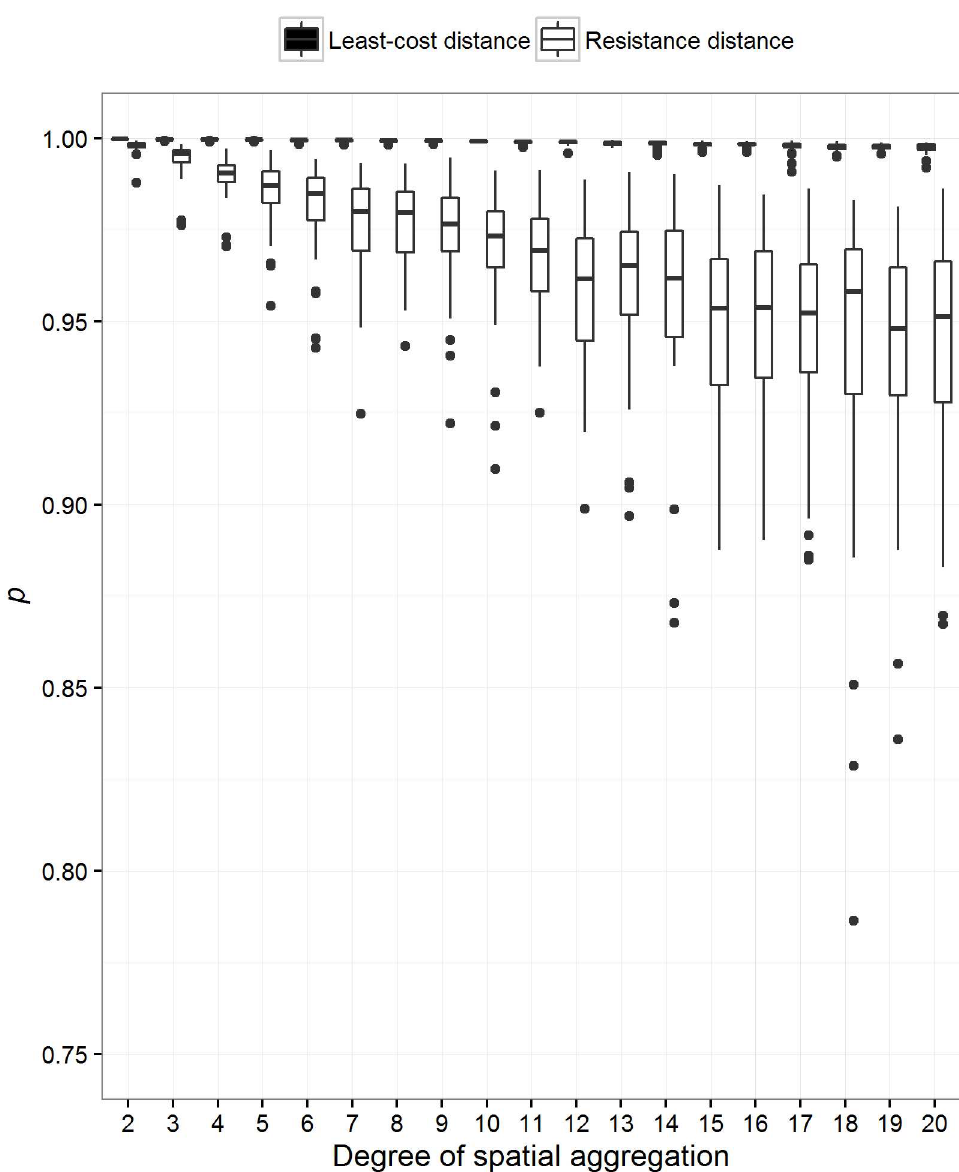
Fig 7. The effect of spatial aggregation on each method. The effect of spatial aggregation on least-cost and resistancedistance. One thousandlandscapes were simulatedwith varying degreesof spatial autocorrelation. Least-cost and resistancedistancebetween15 sites was then calculatedfor all landscapes. These landscapes were then spatiallyaggregatedby a random factor between2 and 20. Pairwisedistances were once again calculated. We then calculatedthe Spearman’s rank correlation between each method before and after aggregation. The degreeof spatialaggregationis simply the spatial aggregationfactor. This figure illustrates the effect of spatial aggregationon either method. Least-costdistanceis not affected by spatialaggregation, but the effect of aggregationon resistancedistancemonotonically increaseswith the degreeof spatialaggregation. Both least-cost and resistance distances estimates responded much differently to the Euclid- ean distance between focal points, when measured on a log-log scale. They both have linear relationship with Euclidean distance, but the rate of increase of least-cost distance was ~500 times higher than resistance distance. Hence, least-cost distance is more sensitive to changes in Euclidean space when compared to resistance distance. Seeing as Euclidean distance alone